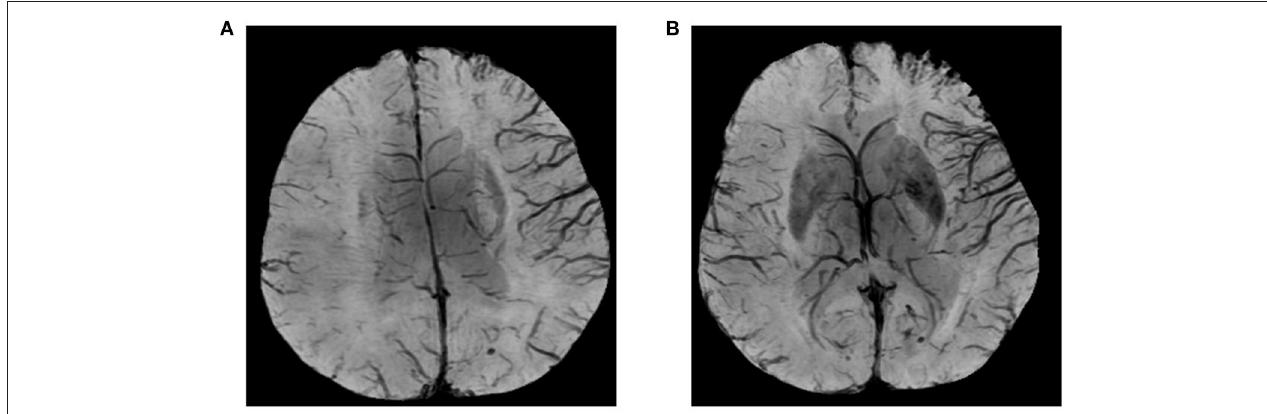
FIGURE 1 | Images illustrating prominent hypointensity vessel sign (PVS) and SWI-ASPECTS: blood supply in area of right middle cerebral artery (M1, M2, M3, insula, M4, M5, and M6) showing prominent PVS; and thalamostriate venous none-dilatation (SWI-ASPECT of 3).